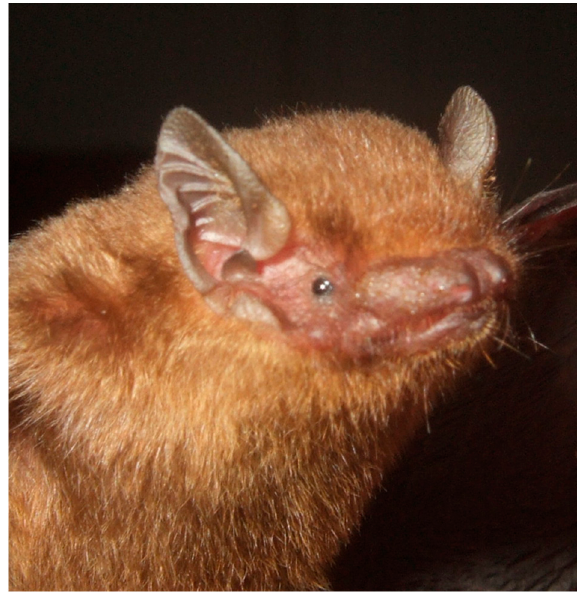
Figure 24. Tylonycteris fulvida , adult female. Photograph by Vu Dinh Thong.